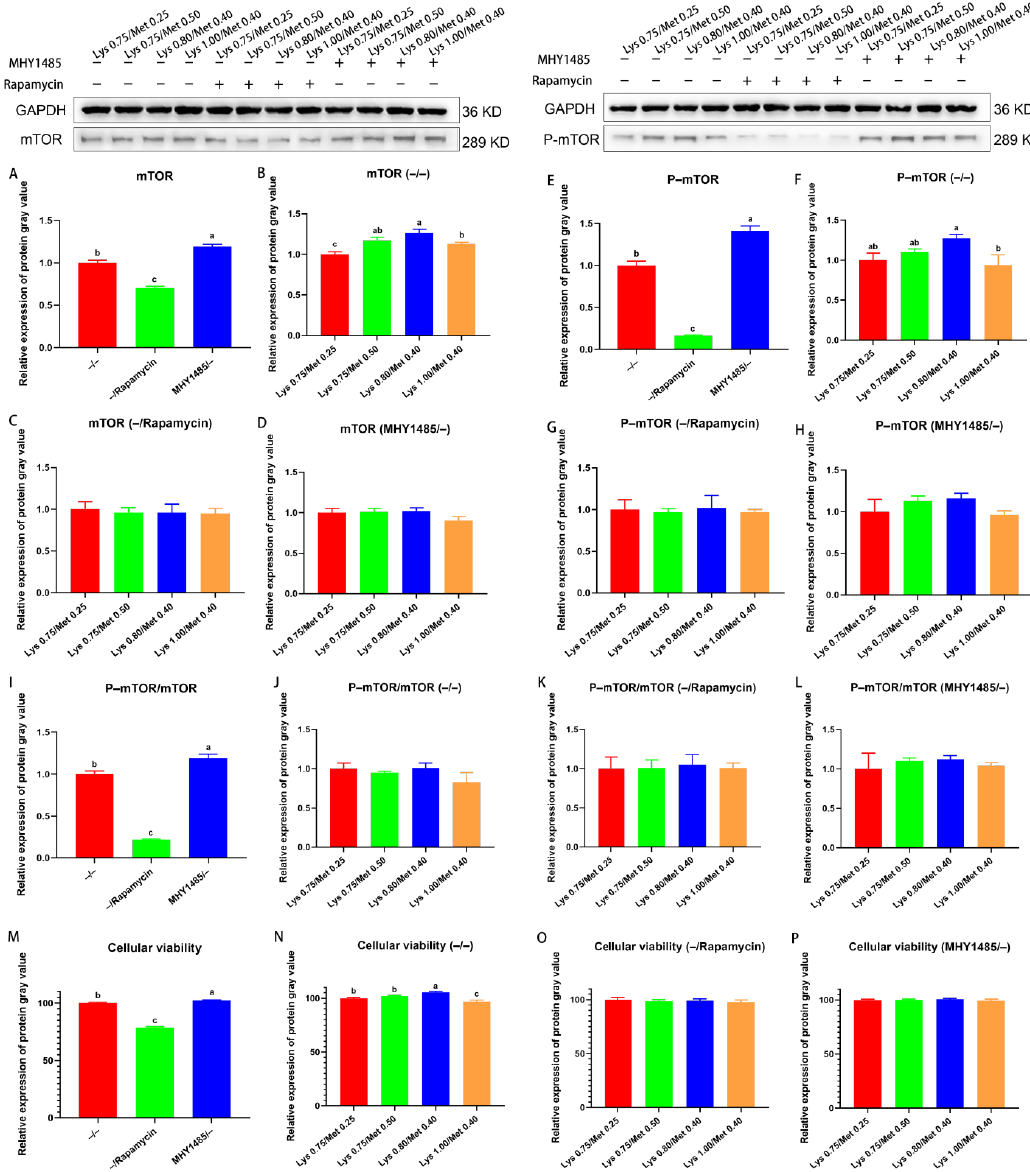
Figure 4. Effects of different lysine and methionine composition on mTOR signaling pathway and